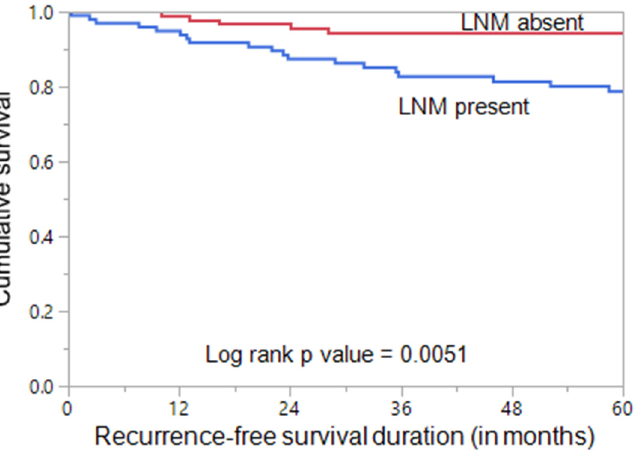
Figure 1. Recurrence-free survival (RFS) in papillary thyroid microcarcinoma (PTMC). Kaplan– Meier survival curve showing a shorter recurrence-free survival in PTMC patients with lymph node metastasis (LNM) than in those without LNM ( p = 0.0051). Table 4. Multivariate analysis using a Cox proportional hazards model for predictors of recurrence- free survival (RFS) in PTMC.